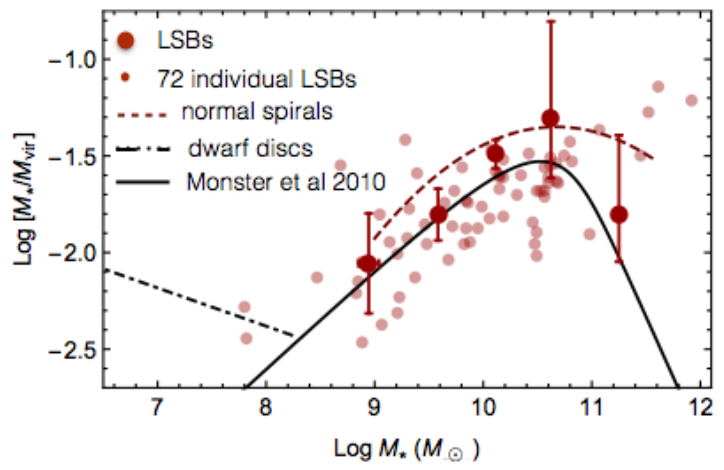
Figure 22. Fraction of baryonic matter is LSBs vs. their mass in stars (points) compared with that of: normal spirals (dashed line) [180], various Hubble types (solid line) [247] and dwarf discs (dot-dashed line) [30]. Image reproduced from